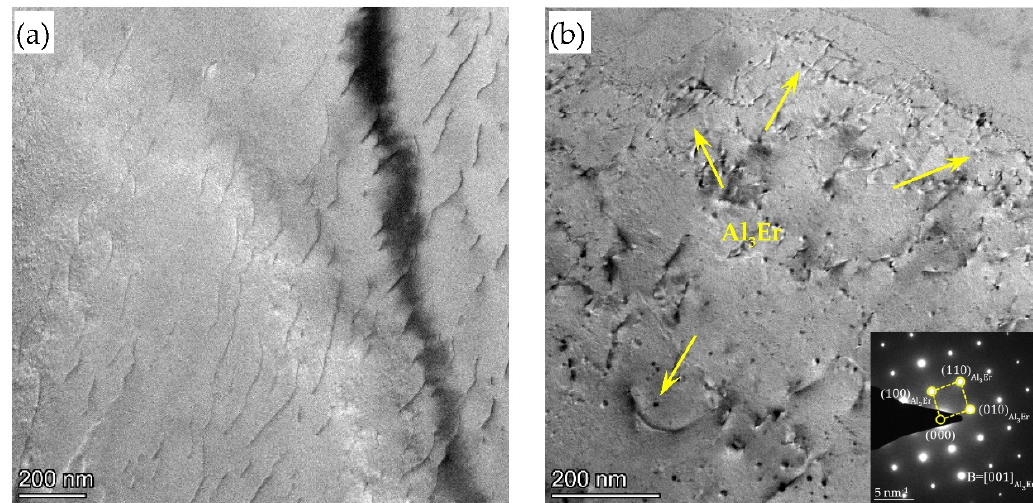
Figure 13. TEM images of the Al-5Zn-0.03In-1Er alloy: ( a ) as-cast, ( b ) 615 °C × 32 h.